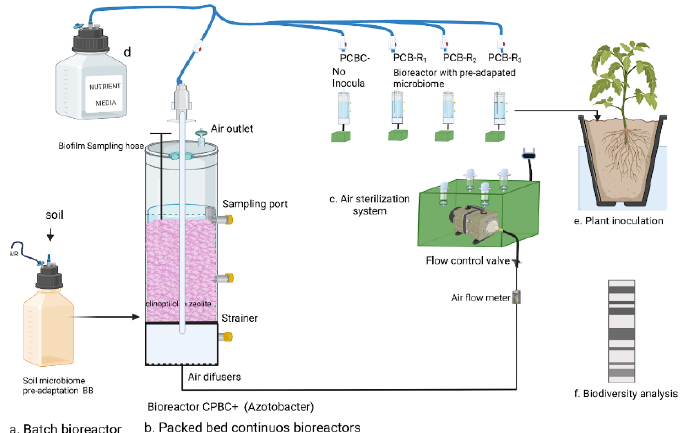
Figure 1. Experimental setup. ( a ) Batch bioreactor (BB) was fed with glucose-citrate as the only carbon source and N-depleted; ( b ) set of continuously packed bioreactors (PcB-R1 to PcB-R3 and PcB-C+), fed with citrate as the only carbon source and N-depleted; ( c ) sterile box provided with Nylon Syringe Filter, 0.22 µm and pump. The sterile air reaches the bioreactors through a plastic conduit. ( d ) Media supply; ( e ) pot model for plant inoculation; ( f ) 16srARN was used for microbial analysis.